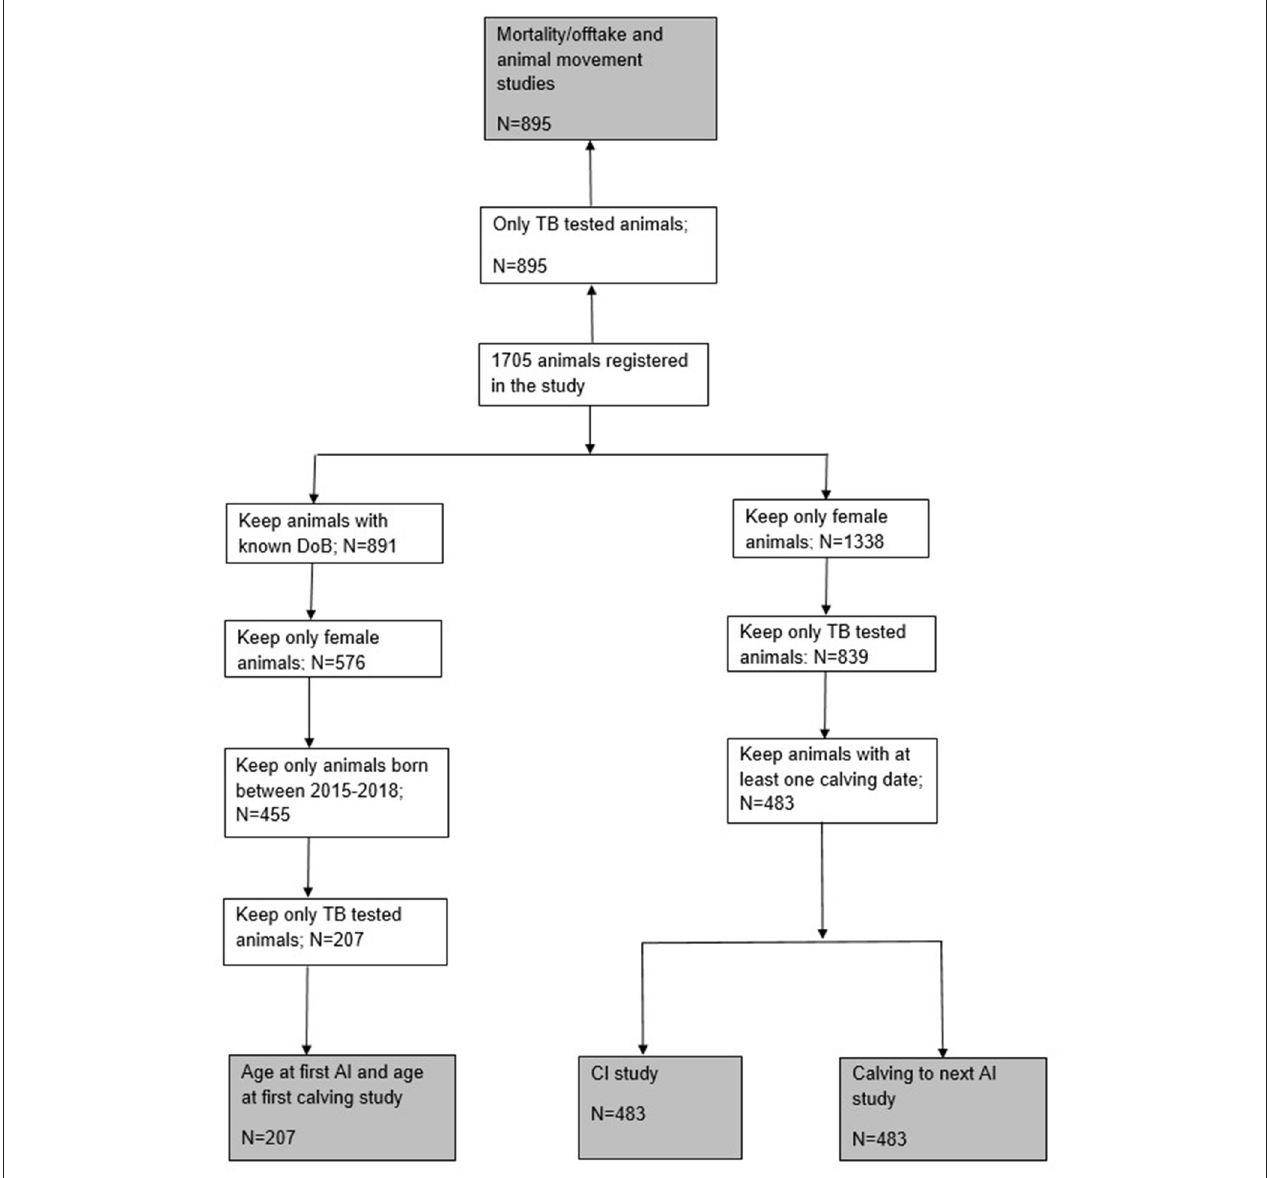
FIGURE 1 | Flowchart showing animals used for each study